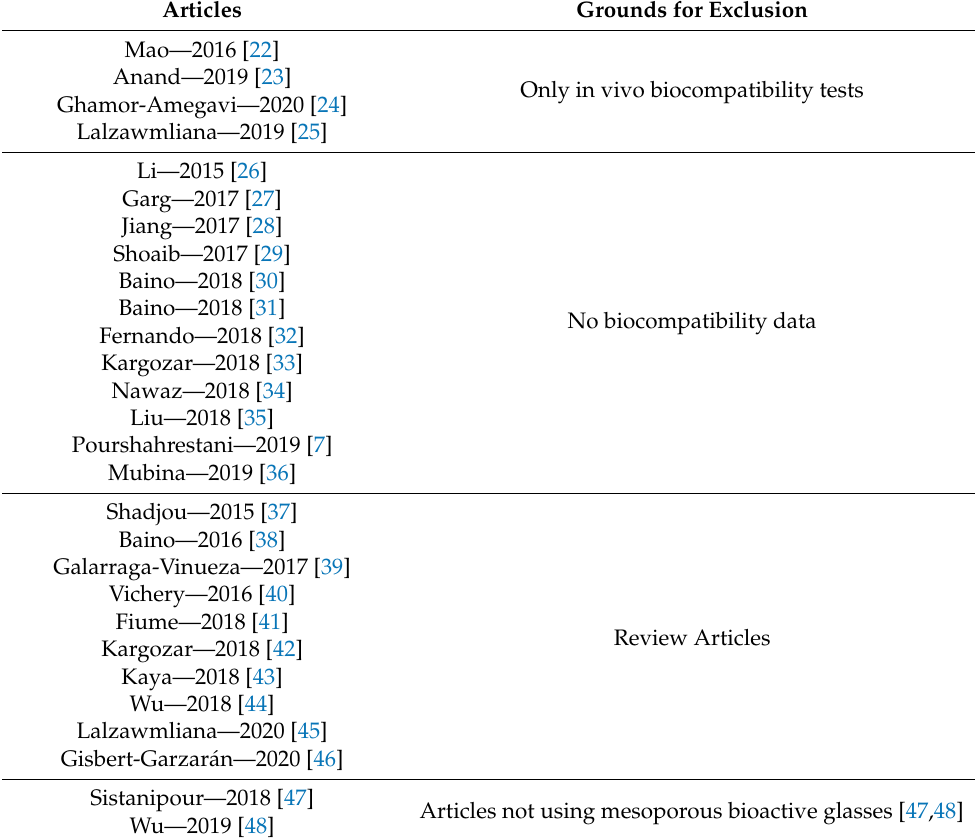
Table 2. Articles excluded and their grounds for